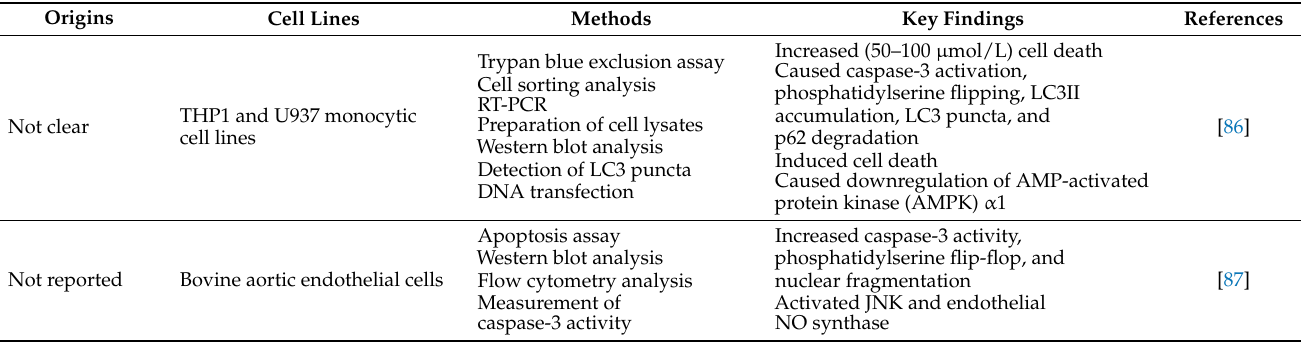
Table 4. Anticancer activities of